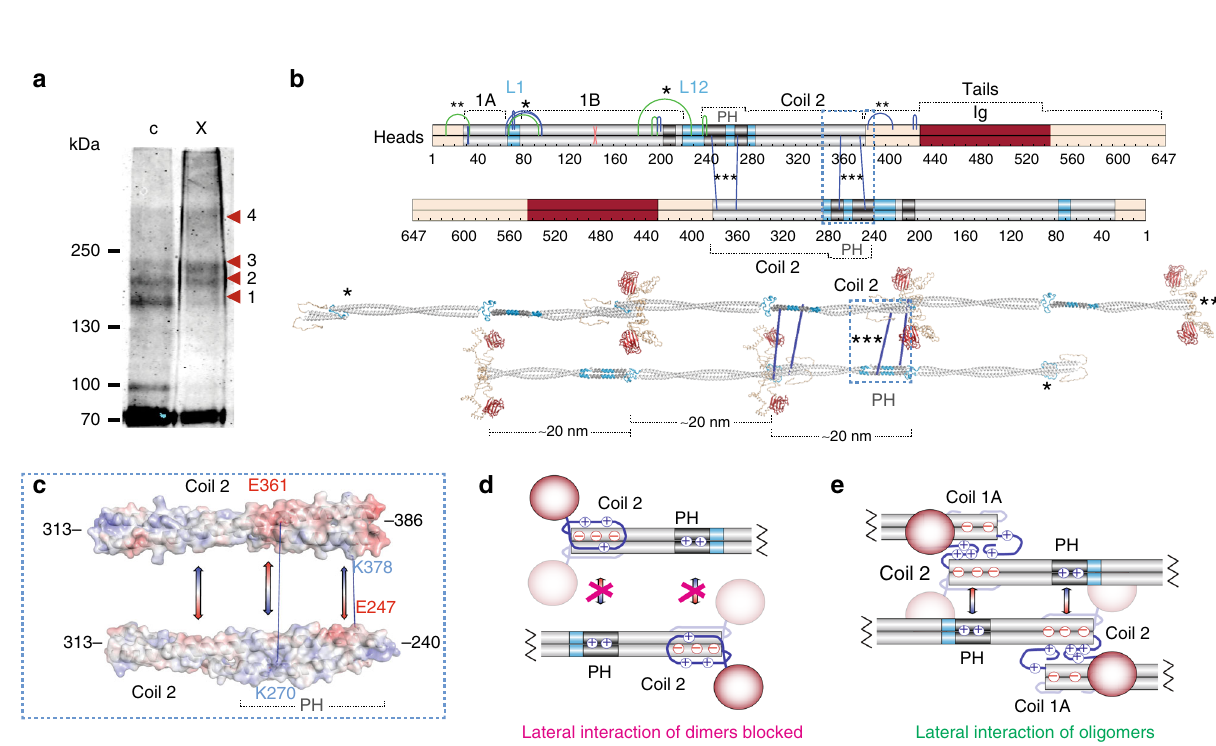
Fig. 9 Ex vivo nucleoskeleton cross-linking indicates lateral strand assembly. a Lamin A Western blot of uncross-linked and cross-linked rat liver nuclear envelopes. Bands 1 – 4 appear before cross-linking and changes in band intensities parallel in vitro cross-linking, attesting to successful cross-linking. b Fifteen cross-links (top schematic) identi fi ed ex vivo: fi ve were not previously seen in vitro (green) and 10 directly recapitulated in vitro results. Previously in-vitro-encountered cross-links E65-K97 and E68-97 (asterisk) and an additional cross-link E68-S94 all suggest coil 1A and L1 folding over coil 1B, thus recapitulating in vitro conclusions. Similarly, a cross-link D192-S239 indicates L12 and PH folding over coil 1B (asterisk) again recapitulating in vitro fi ndings. Folding of the head and tail onto the adjacent rod termini was recapitulated in cross-link S12-E33 and in the previously seen E385-S407 cross-link (double asterisk). Inter-dimeric K270-E361 and E247-K378 (triple asterisk) cross-links were consistent with a lateral anti-parallel half-staggered dimer interface in fi laments (bottom model). One cross-link S143-E145 (red) was strictly intra-molecular in vitro, but was inter-molecular (between overlapping peptides) ex vivo. c Alignment of coil 2 fragments with electrostatic potential overlay: negative (red), positive (blue). Gradient- fi lled arrows indicate potential weak electrostatic attractions. d , e Differences in spectra recovered between dimeric ( d ) and tetrameric ( e ) species suggest that these electrostatic interactions are likely blocked by the tail unstructure regions between dimers, but possible between head-to-tail oligomers. Source data for panel a are available in the Source Data fi